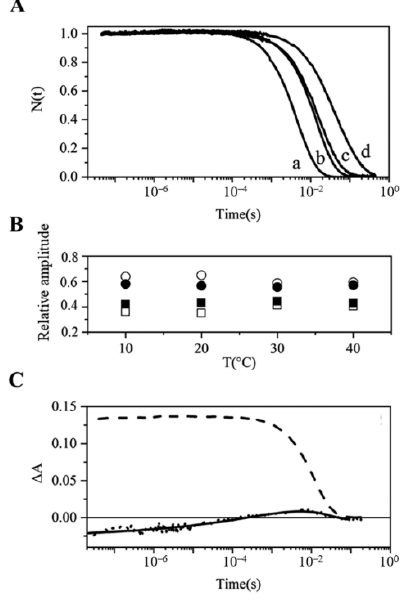
Figure 6. CO rebinding kinetics of Mt -Nb(II) after nanosecond laser photolysis at pH 7.4. ( A ) The progress curves of CO rebinding to Mt -Nb(II) (obtained at 436 nm, 10.0 ◦ C (b, d), 40.0 ◦ C (a, c), 0.2 CO atm (c, d) and 1.0 CO atm (a, b)) were normalized to the absorbance change at the end of the pulse. ( B ) Relative amplitudes of the two bimolecular kinetic phases for Mt -Nb(II) carbonylation (squares: fast reaction; circles: slow reaction; open symbols, 0.2 CO atm, filled symbols, 1.0 CO atm). ( C ) Transient absorbance traces after photolysis of the CO- Mt -Nb complex at 20.0 ◦ C. The solution was equilibrated with 1.0 atm of CO at 436 nm (dashed line) and 421.5 nm (dotted line, displayed on a × 4 scale); the solid line is the result of the fitting with the sum of a stretched exponential relaxation (lifetime 770 µ s, stretching exponent 0.24) and an exponential relaxation (lifetime 29